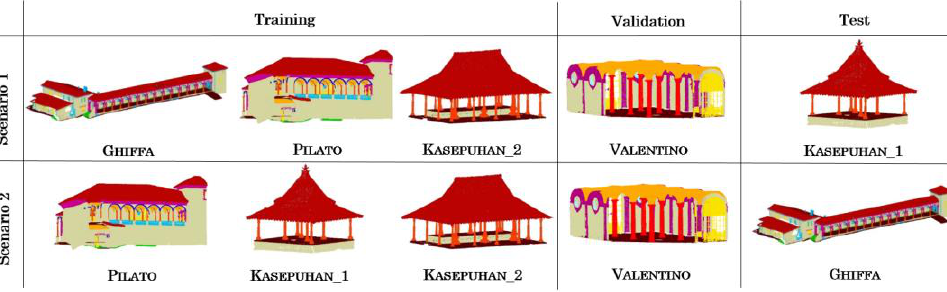
Figure 2. Configuration of the different datasets used in the two scenarios for the second